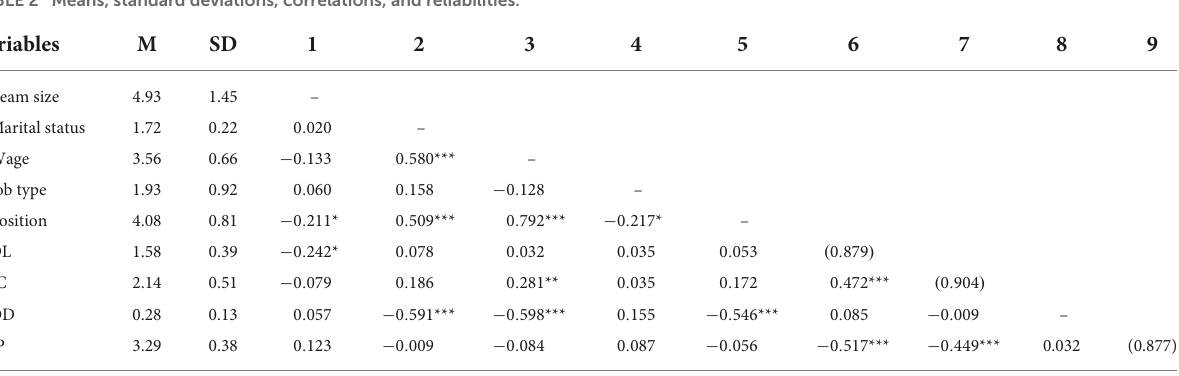
TABLE 2 Means, standard deviations, correlations, and reliabilities.